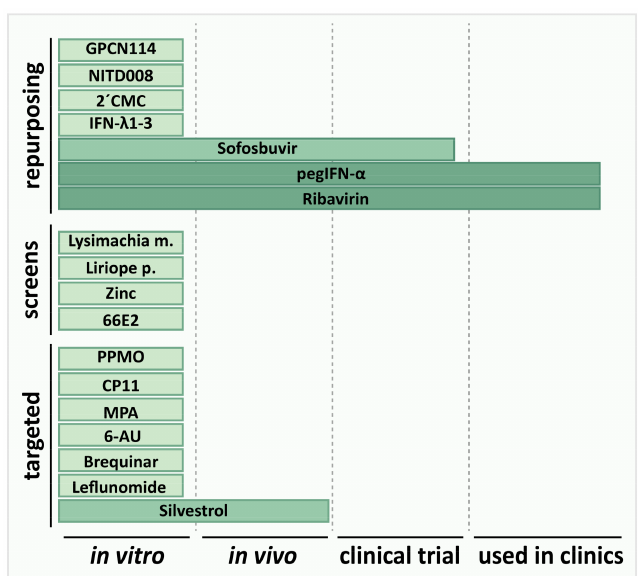
Figure 3. Overview of molecules / extracts with antiviral activity against HEV. The depicted molecules / extracts are classified according to the strategy that was used to identify them. So far, the antiviral activity against HEV of only four drugs (Sofosbuvir, pegIFN- α , Ribavirin and silvestrol) was approved in experimental settings beyond in vitro cell culture systems. Both drugs in the clinics are used o ff -label and therefore have not been tested in clinical trials against